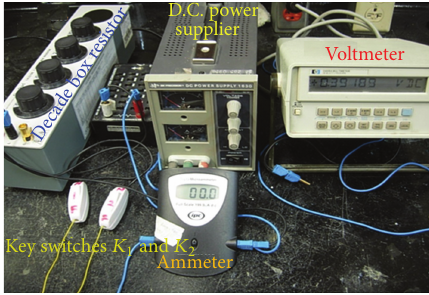
Figure 2: Photograph showing components of the developed setup.